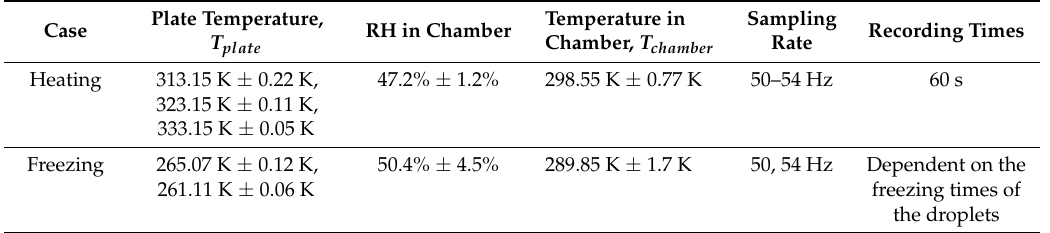
Table 2. Experimental setup